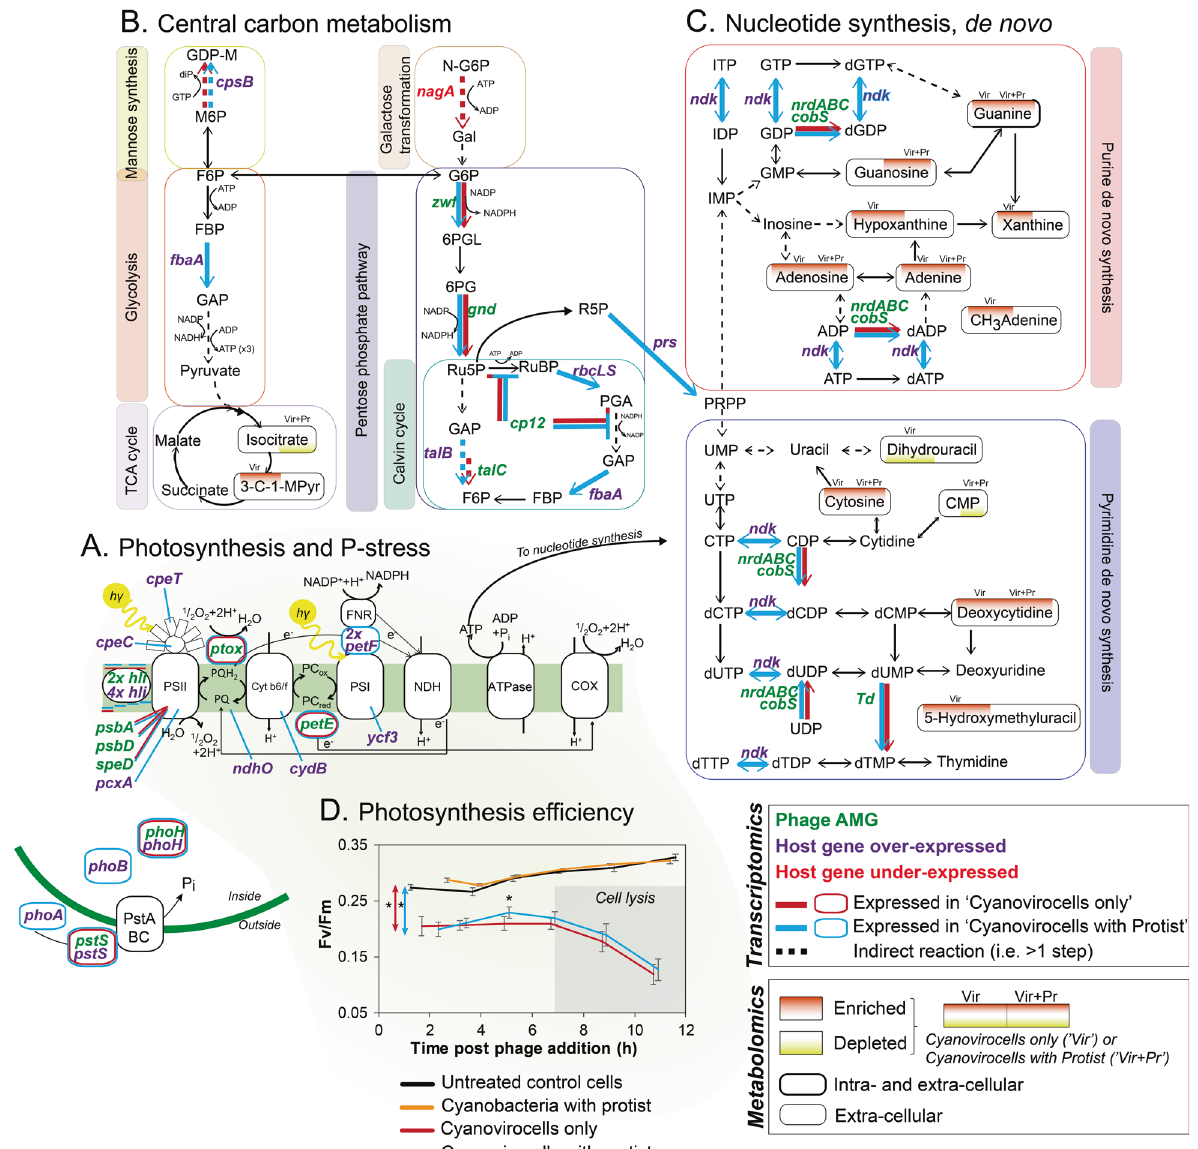
Fig. 4 Cyanovirocell energy and resource metabolic pathways responding to the protist. A Photosynthesis and phosphate (P) stress. B Central C metabolism, including mannose synthesis, glycolysis, galactose metabolism pentose phosphate pathway (PPP), Calvin cycle, and the Tricarboxylic acid (TCA) cycle. C De novo purine and pyrimidine nucleotide synthesis. Phage auxiliary metabolic genes (AMGs) are in green text. Host over-expressed genes are in purple, while the under-expressed one is in red. The color of the arrow or the border (orange or blue) denotes if the gene is expressed in response to phage only or phage and protist. Metabolites that change signi fi cantly have a background shade colored red (if enriched) or yellow (if depleted) and the position of the shade denotes under which treatment they are altered: in the cyanovirocells only or in the cyanovirocells co-cultured with protists. D Photosynthetic ef fi ciency of Synechococcus cells under each condition. Asterisks indicate when treatments are signi fi cantly different ( t -test, p value <0.05). Cyanovirocells and cyanovirocells with protist both have signi fi cantly lower photosynthetic ef fi ciency than uninfected cells (red and blue arrows with asterisks, respectively), but cells with just the protist do not ( t -test, p value >0.05). Cyanovirocells with protist signi fi cantly increase in photosynthetic ef fi ciency from ~2 to ~5 h post infection relative to cyanovirocells alone ( t -test, p value <0.05). Abbreviations can be found in the Supplementary phoH ), (ii) photosynthesis ( petE, ptox, hli ( n = 2), psbA , psbD, speD ), AMGs from central C metabolism pathways inhibit the Calvin (iii) central C metabolism ( zwf, gnd, talC, cp12 ), and (iv) nucleotide cycle to prevent ATP consumption and to redirect C fl ow toward synthesis ( nrdA , nrdB, nrdC, td, cobS ) (Fig. 4A – C) [31, 32, 78], and the PPP, from which NADPH and ribose-5-phosphate are were all expressed regardless of protist presence (Supplementary obtained. With these resources, as well as with acquired P (with Table S4 and Supplementary Fig. S6). Contrastingly, the cyanovir- P-stress transporters), cyanophages can replicate their genomes ocells over-expressed 4 and 23 (the same 4 plus 19 more) host (reviewed in [31, 78]; Fig. 4A – C). genes in the absence and presence of the protist, respectively, We next examined the expression of the phage AMGs and host relative to the control (Supplementary Table S5 and Supplemen- genes involved in those metabolic pathways. Phage S-SSM5 tary Fig. S7). These genes are for (i) P-stress ( phoA, phoB, pstS and encodes AMGs involved in all of these pathways: (i) P-stress ( pstS,